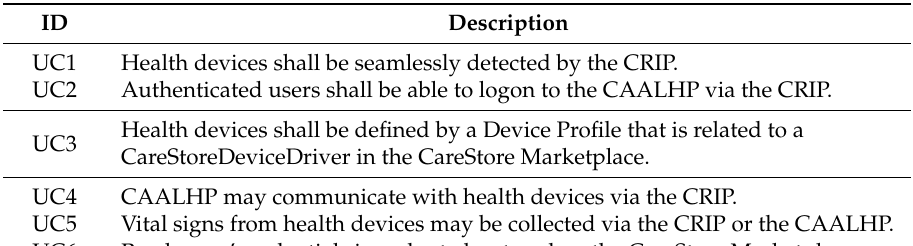
Table 2. List of use cases of the CRIP.